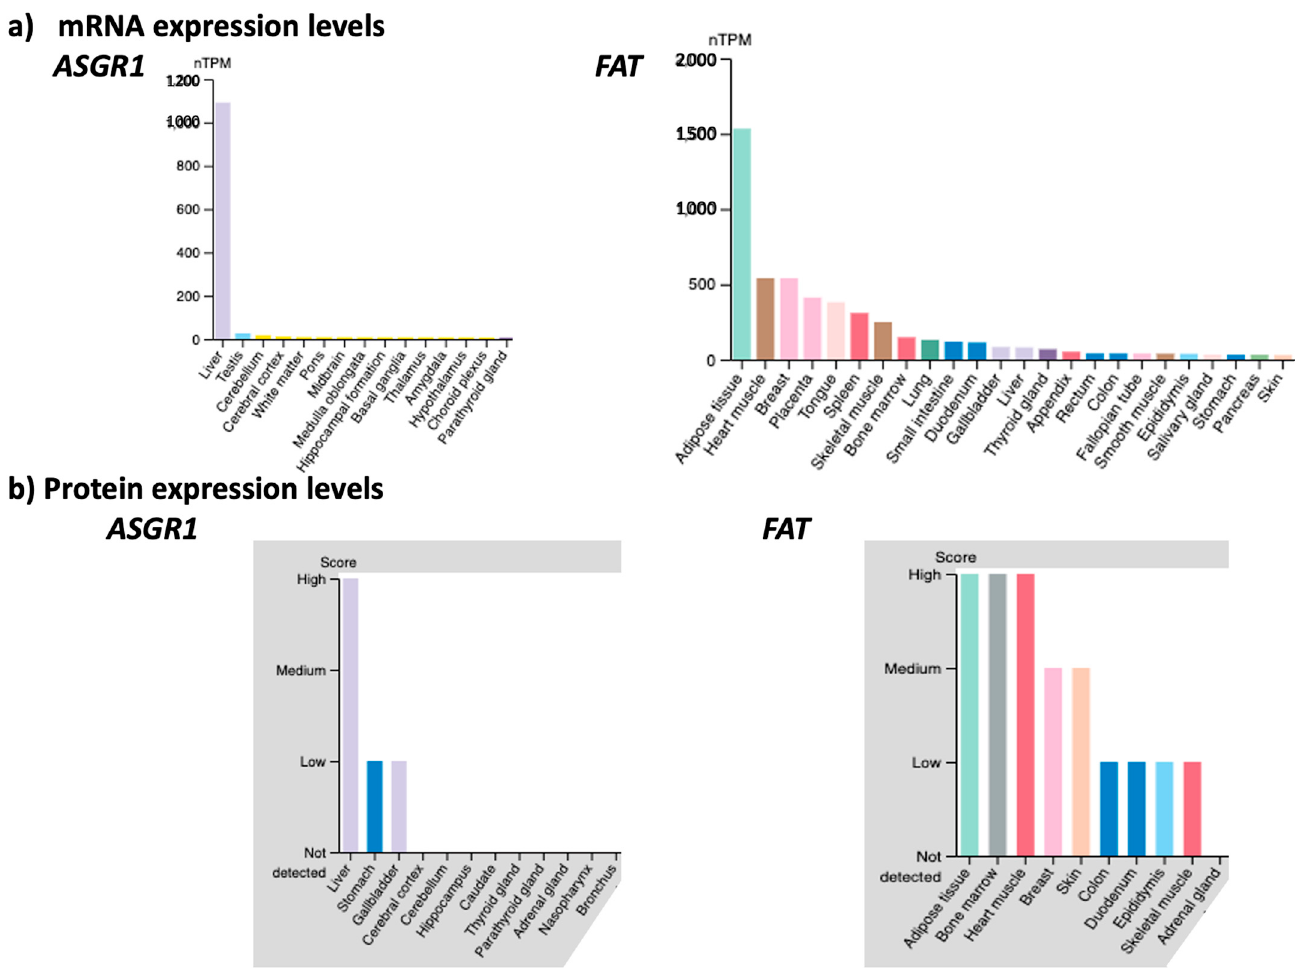
Figure 7. Comparison of mRNA ( Panels a ) and protein ( Panels b ) expression levels in various tissues and organs of the asialoglycoprotein receptor 1 (ASGR1) and the fatty acid translocase (FAT) membrane transporter (nTPM = normalized transcript per million) (www.proteinatlas.org (accessed on 27 March 2023)). The figures are shown in “Expression Level” mode in decreasing order from left to right. The tissues/organs with little or no expression are not shown for sake of